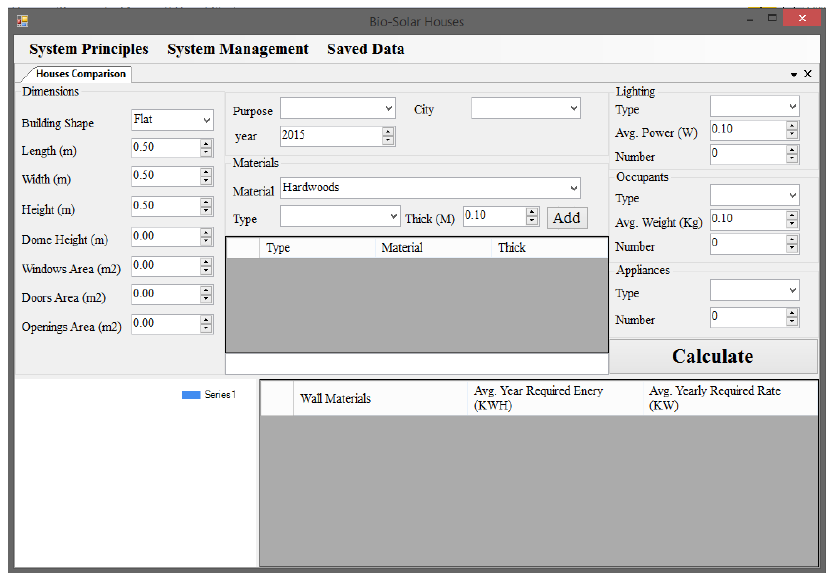
Figure 5. Houses performance form in model.